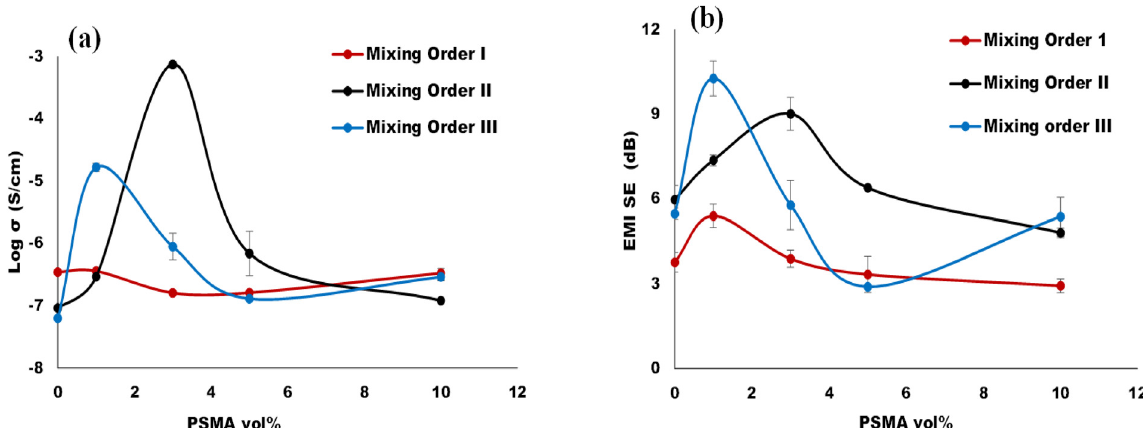
Figure 9. Properties obtained via different mixing orders. ( a ) Electrical conductivity and ( b ) EM SE of melt processed PS/aPA (25:79) as a function of PSMA content.